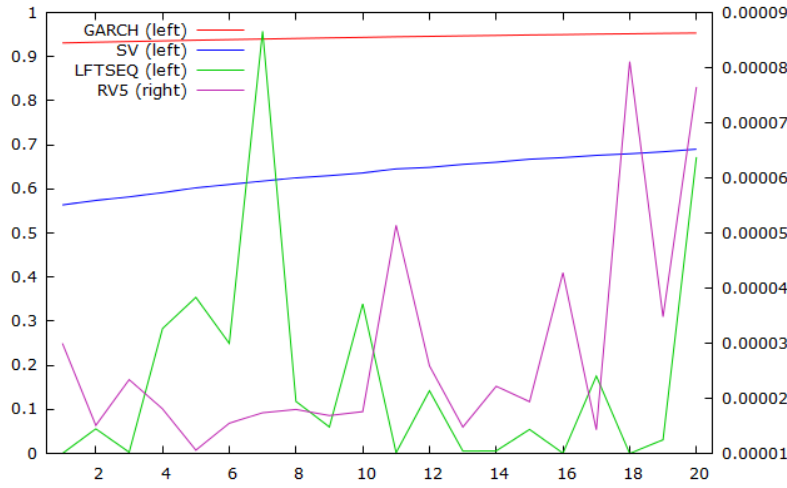
Figure 10. Prediction plots for last 20 observations by SV and GARCH, and values of lagged DMSQFTSERET and